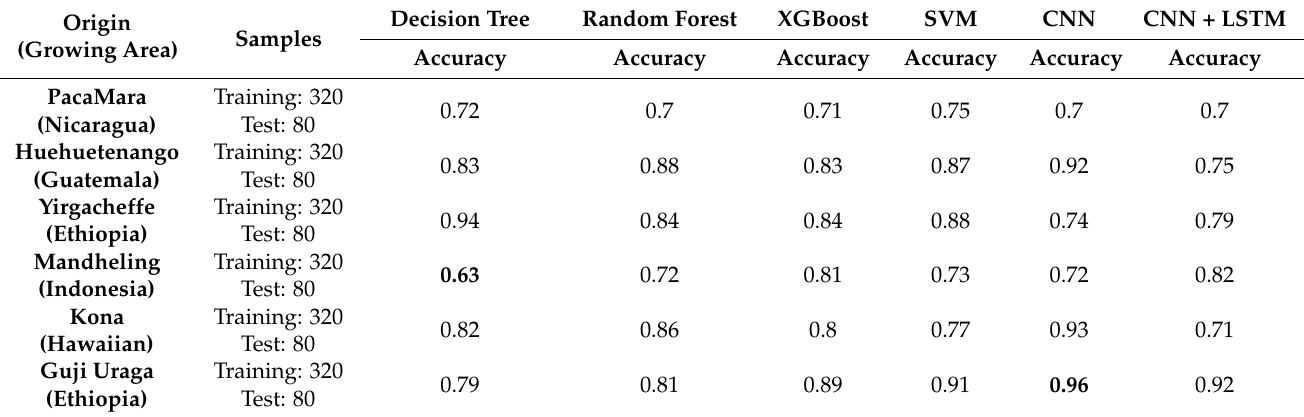
Table 5. Classifier performance results in scenario using 6-class predictions (experiment